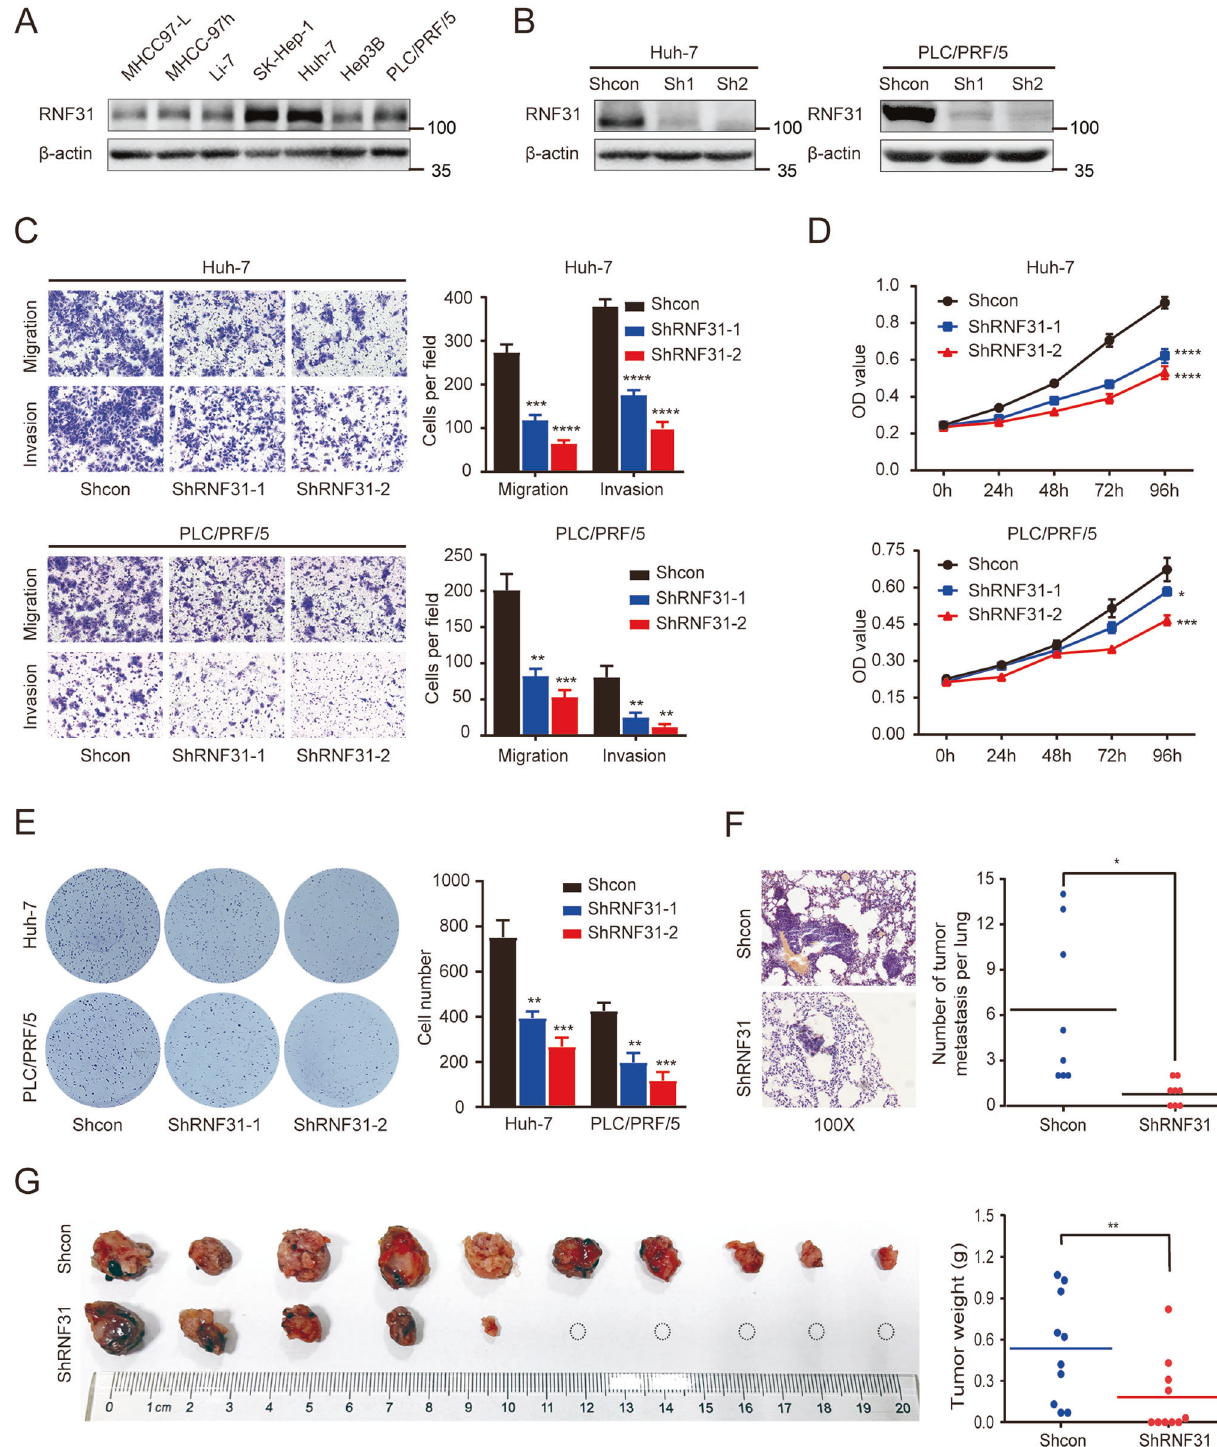
Fig. 2 Down-regulation of RNF31 inhibits the migration, invasion, and proliferation of HCC cells in vitro and in vivo. A RNF31 protein levels were determined in seven HCC cell lines by performing a western bolt. B RNF31 knockdown ef fi cacy was con fi rmed by western blot. C Representative images of migration and invasion assays for the RNF31 knockdown and the control HCC cells. The cells were counted under the microscope at ×100 magni fi cation in fi ve randomly selected single fi elds of vision. D CCK-8 assay was performed to investigate the effect of RNF31 knockdown on proliferation of PLC/PRF/5 and huh-7 cells. E Clone formation assay was performed to assess the clone formation abilities of the control and the RNF31 knockdown HCC cells. F Typical images of HE staining of pulmonary metastases. Lung tumor metastasis in mouse models was established by tail vein injection of control and RNF31 -silenced huh-7 cells. G Effect of stable RNF31 knockdown on huh- 7 cells growth in vivo by measuring the tumor weight. (* p < 0.05, ** p < 0.01, *** p < 0.001, **** p < 0.0001).